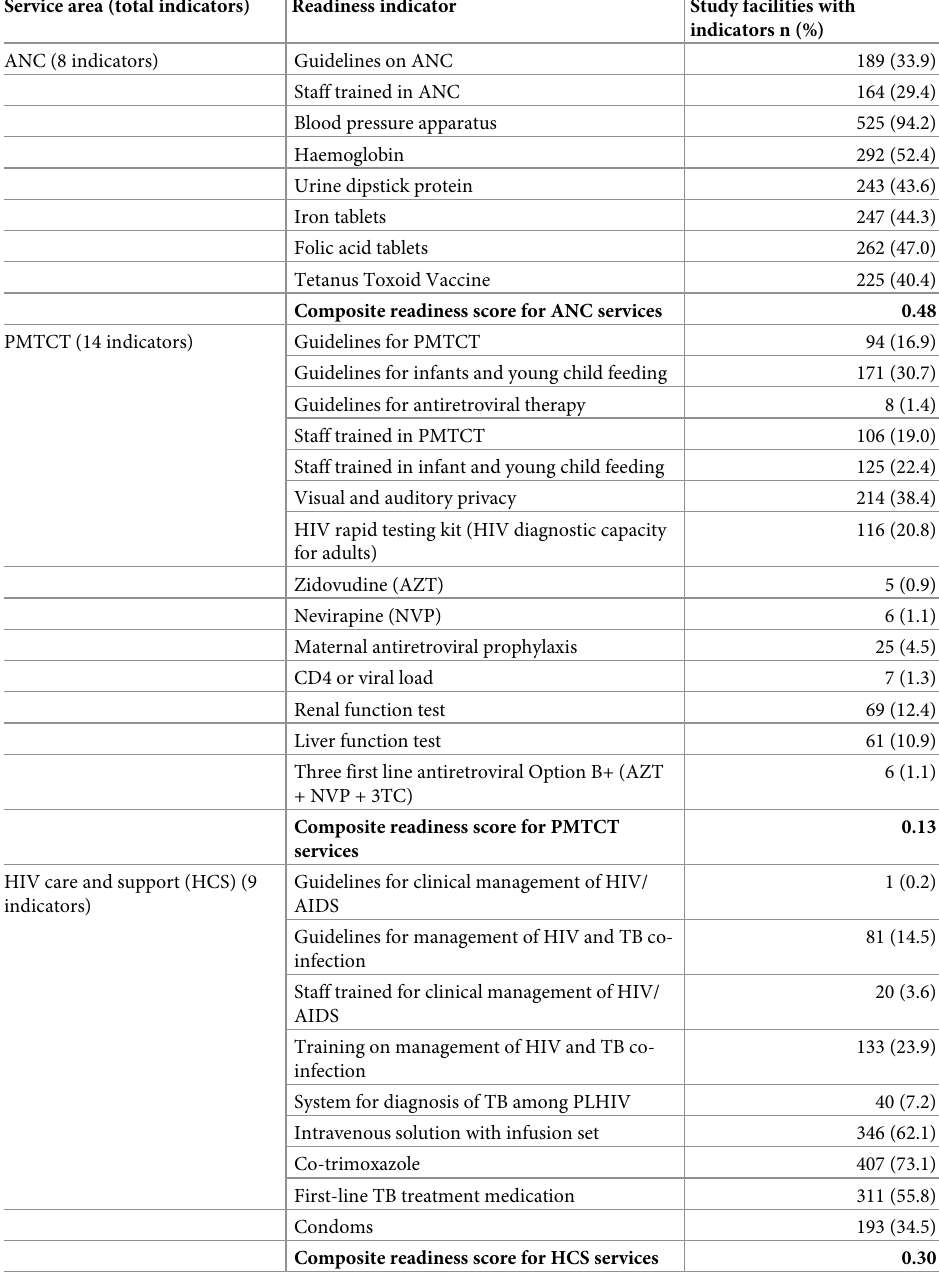
Table 1. Service readiness indicators for ANC, PMTCT and HCS in